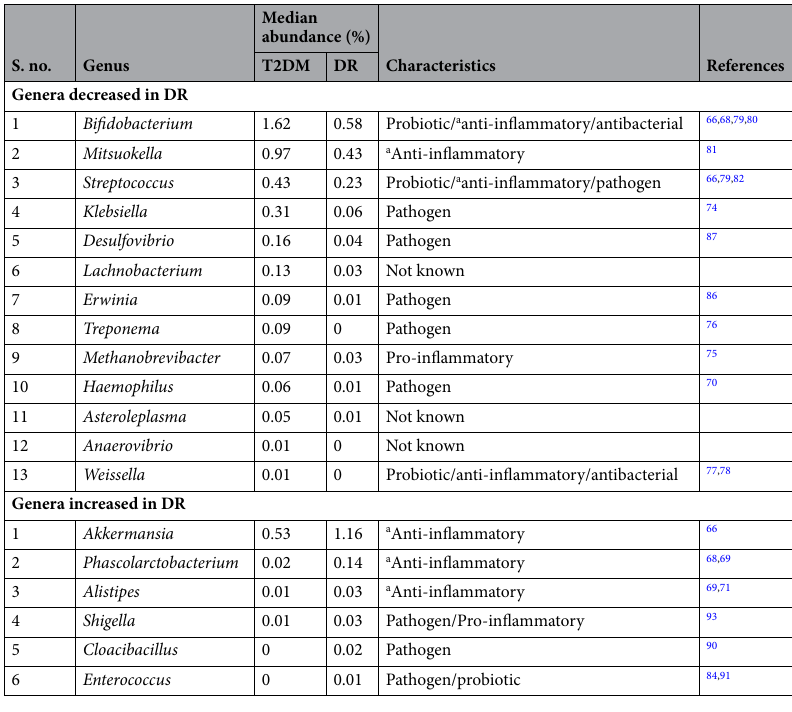
Table 5. Bacterial genera exhibiting significant differential abundance (BH corrected p < 0.05) between the gut microbiomes of type 2 diabetes mellitus (T2DM, n = 24) and diabetic retinopathy (DR, n = 28) individuals. a Based on the capability to produce short chain fatty